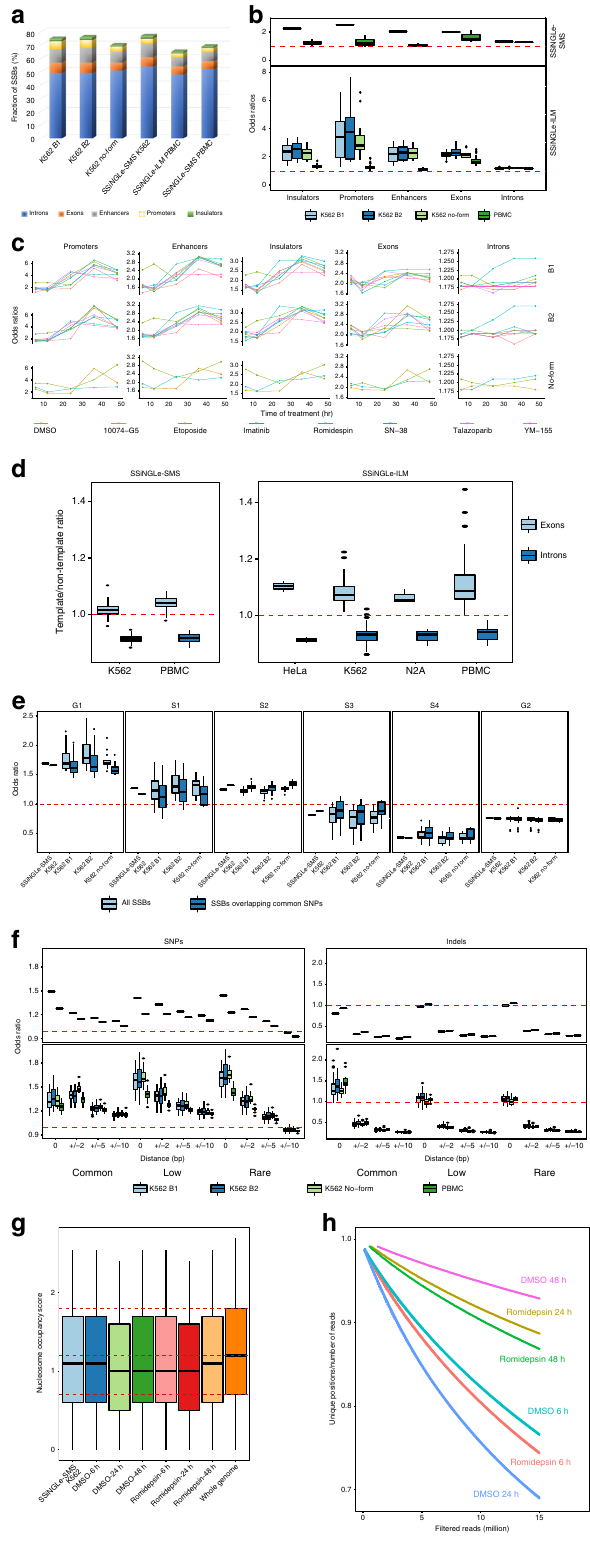
the corresponding ranges of (1.3 – 7.6), (1.4 – 3.2), and (1.3 – 3.4) (Supplementary Data 6). Since all treatments, including the likely that the time-dependent enrichment pattern re fl ected